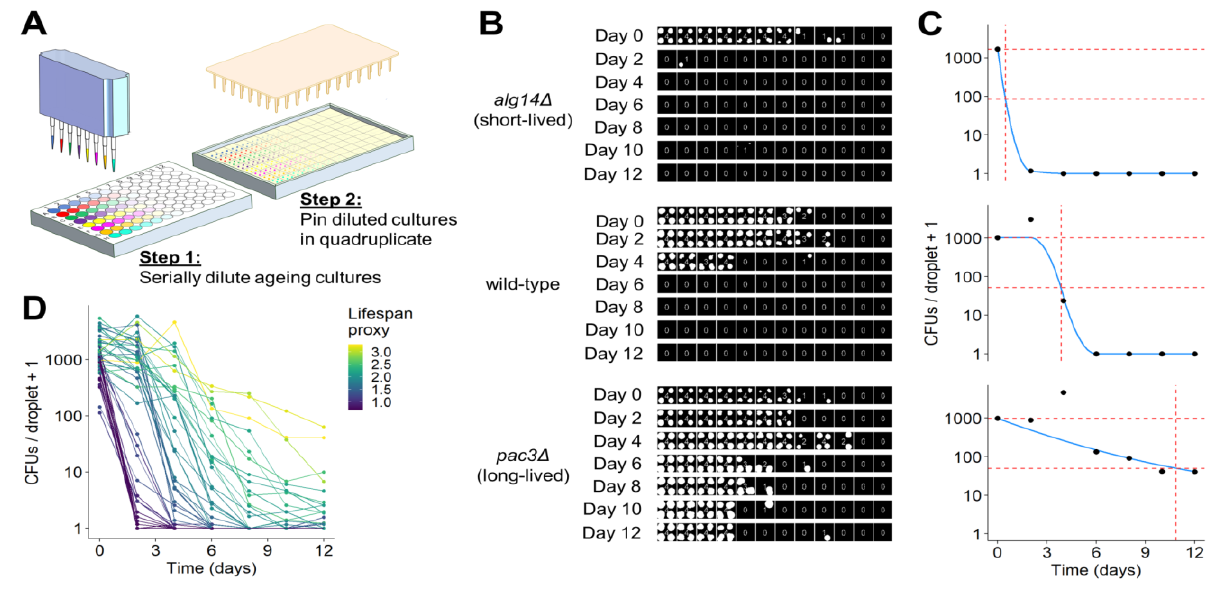
FIGURE 3: Development of robotics-based CFU assay. (A) Scheme of high-throughput CFU protocol. Aliquots of ageing cultures are loaded into the first column of a 96-well plate (8 in parallel) and serially diluted 3-fold across the plate using a liquid-handling robot or multichannel pipette. Droplets of diluted cultures are spotted onto solid agar in quadruplicate using a pinning robot (384-well format). (B) Agar plates are scanned after two to four days of growth, and images analysed using our R package, DeadOrAlive . Colony-spotting patterns for three strains (wild-type, short- and long-lived mutants predicted from Bar-seq screen) are shown for Days 0 to 12. Each position on the plate is scored for the presence or absence of colonies to quantify the colony-spotting patterns. The quantified pattern is shown at the centre of each quadru- plicate, reflecting the number of colony spots observed at each dilution. Note that this method does not require the number of CFUs which give rise to each colony spot, because the colony-spotting pattern is used to determine the number of CFUs via maximum likelihood estima- tion (C). (C) Maximum likelihood estimates for the number of CFUs per droplet plotted against time for the three samples in B. Blue lines show constrained smoothing spline fitted to each CLS curve. Red horizontal dashed lines represent numbers of CFUs per droplet at Day 0 (100% viability) and at 5% viability. Red vertical dashed line represents time at which 5% viability is reached according to the fitted values. The square root of this number was used as lifespan proxy for each sample. (D) Maximum likelihood estimates of CFUs plotted against time for all 47 mutants validated from the Bar-seq screen, plus wild-type control. A CLS proxy was calculated for each sample (C), with each curve being coloured according to the